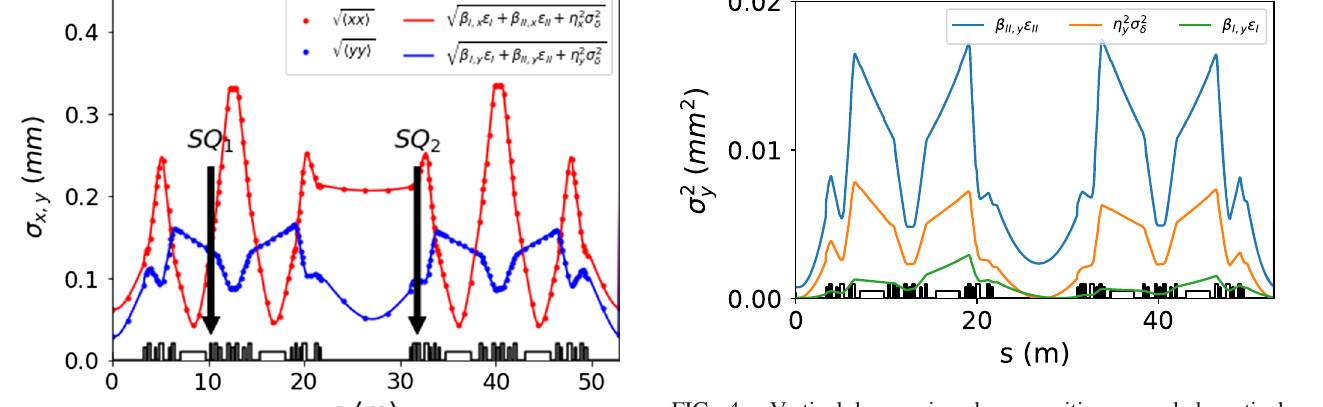
FIG. 4. Vertical beam size decomposition: coupled vertical dispersion (1) generates a considerable amount of mode II emittance contribution, which contributes β II;y ϵ II (blue), (2) in- troduces local energy oscillation, which contributes η 2 y σ 2 δ (yellow); (3) the coupled β I;y function couples some mode I emittance, which contributes β I;y ϵ I